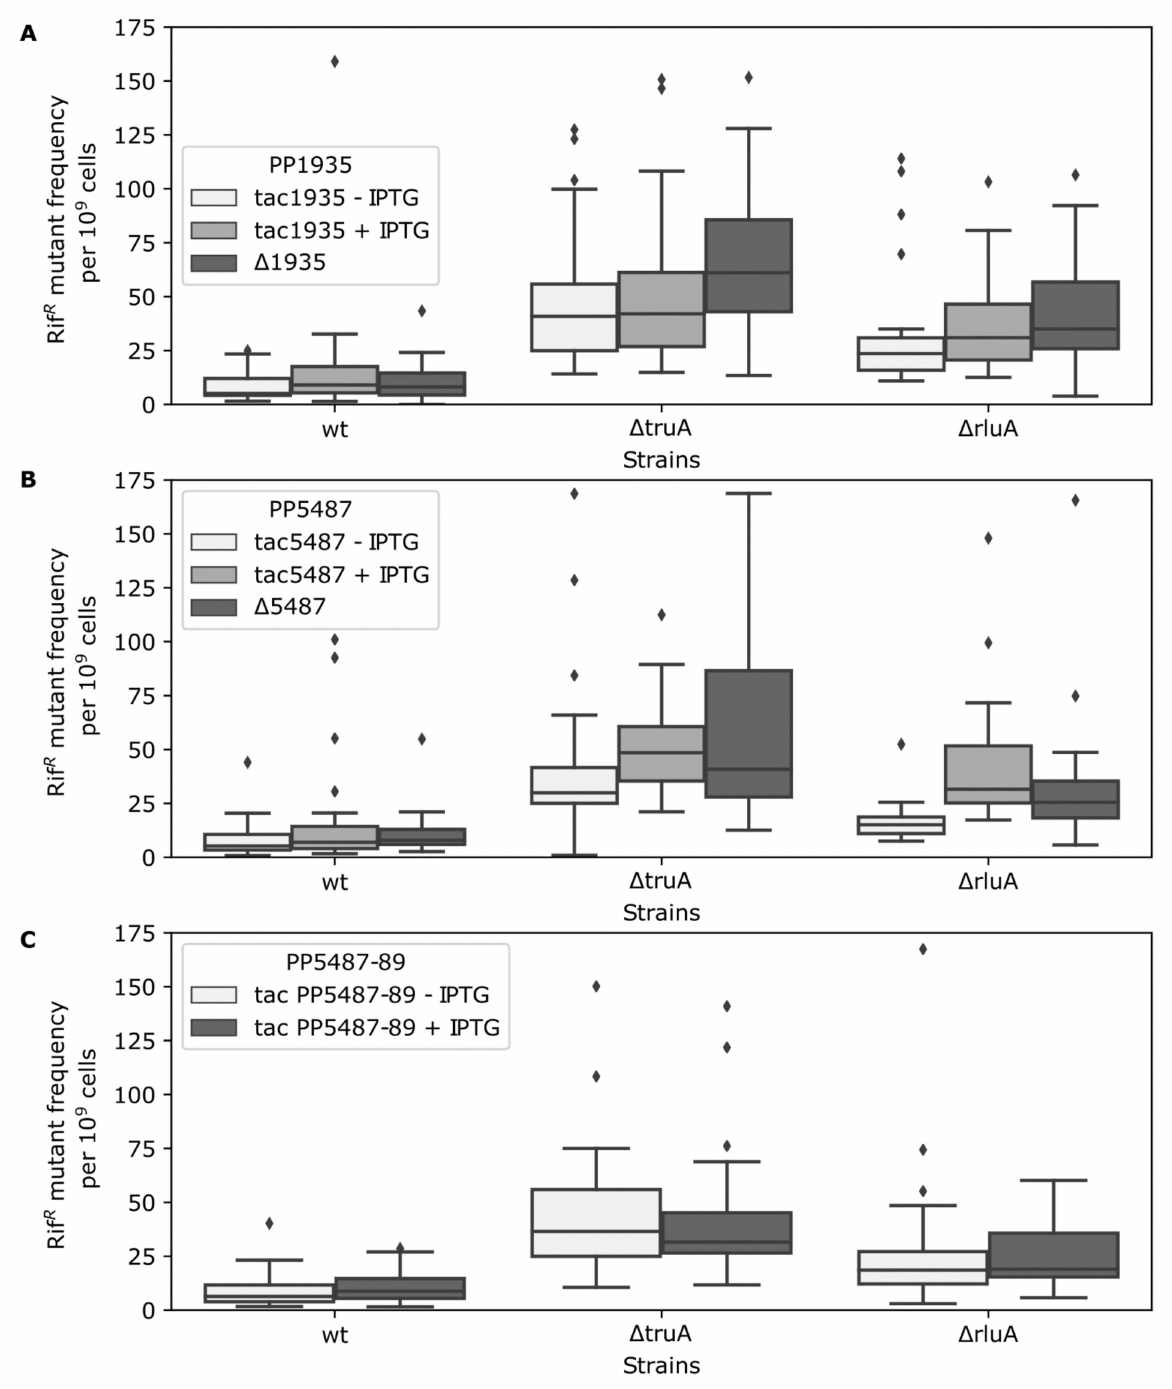
Figure 5. Rif R mutant frequencies of P. putida PaW85 (wt) and truA - and rluA- deficent strains in transcriptional regulator gene PP1935 and operon PP5487-89 backgrounds. ( A ) Mutant frequencies in different strains with altered PP1935 expression. White boxes represent the overexpression of PP1935 without IPTG, light gray the overexpression with IPTG, and dark grey boxes the deletion of PP1935 . ( B ) Mutant frequencies in different strains with altered PP5487 expression. White boxes represent the overexpression of PP5487 without IPTG, light gray the overexpression with IPTG, and dark grey boxes the deletion of PP5487 . ( C ) Mutant frequencies in different strains with altered PP5487-PP5489 operon expression, where white boxes represent the overexpression of PP5487-PP5489 operon without IPTG and light gray boxes the overexpression with IPTG. The mean values (line in the box) of Rif R mutant frequencies per 10 9 cells are presented. The upper and lower borders of the box represent third and first quartile, respectively, the whiskers represent non-outlier range and dimonds indicate outliers. In each strain n = 30 at